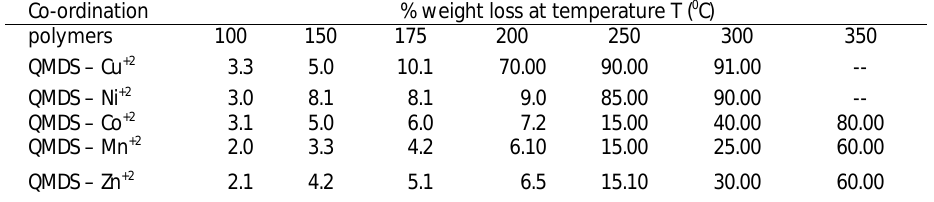
Table IIITable III. Thermogravimetric Analysis (TGA) of the co-ordination polymer of QMDS Co-ordination